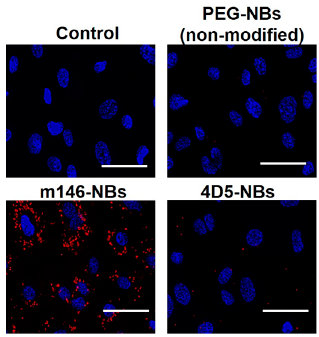
Figure 3. Specific attachment of anti-CD146 antibody-modified NBs to human umbilical vein endothelial cells (HUVECs). HUVECs were incubated with DiI-labeled NBs for 5 min. After incubation, the cells were washed and then treated with DAPI for nuclear staining. The treated cells were examined using a fluorescence microscope. Blue: DAPI fluorescence. Red: DiI fluorescence. Scale bar: 50 µ m.